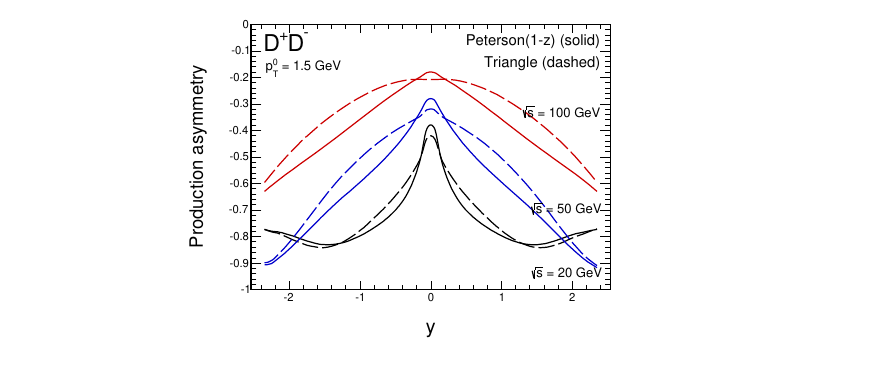
Figure 8. A D + D − ( y ) production asymmetry in proton-proton collisions for di ff erent center-of-mass en- √ s . ergies